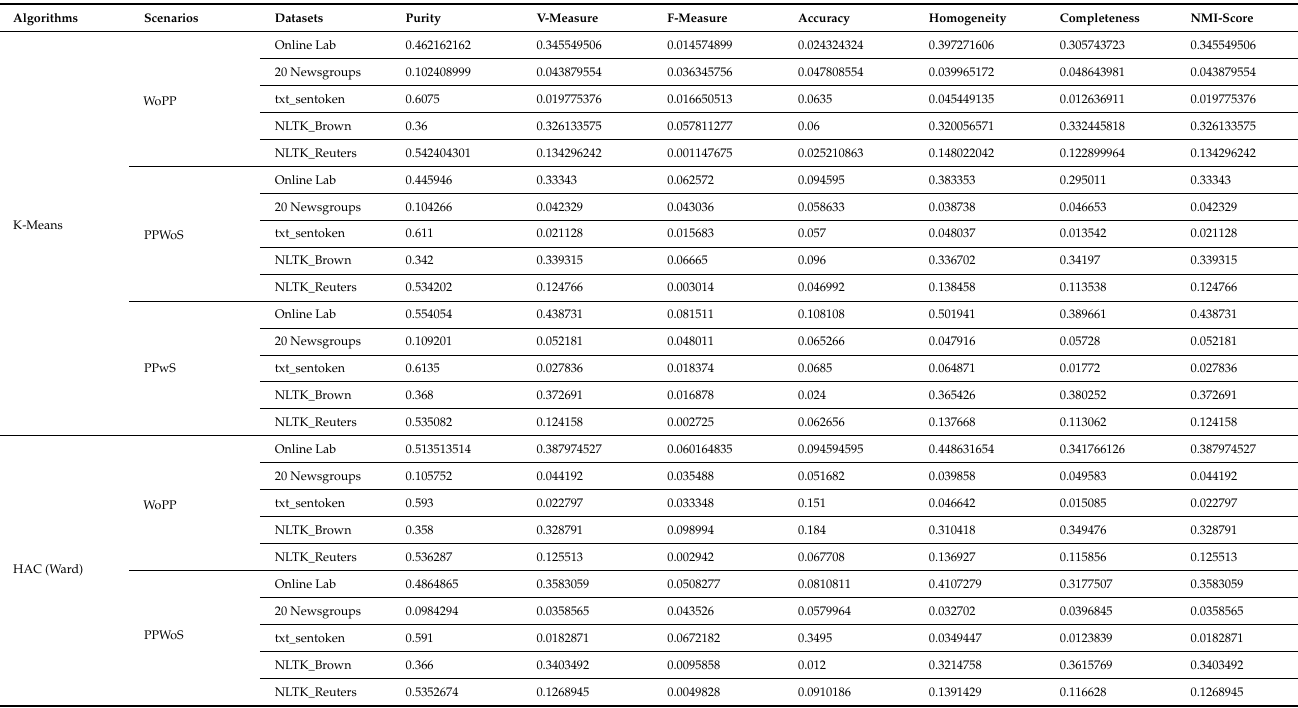
Table 2. External Evaluation metrics for both algorithms with different scenarios for the optimal cluster number